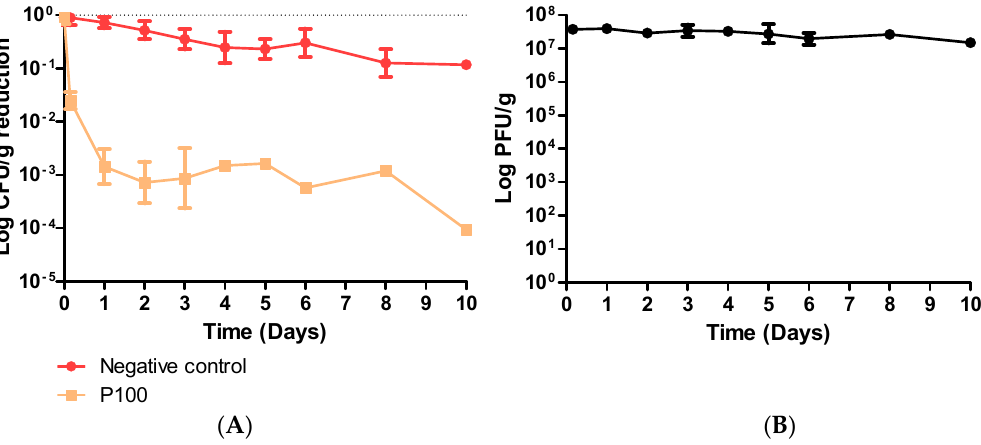
Figure 1. ( A ) E ff ect of P100 on ScottA reduction in coleslaw stored at 4 ◦ C over a 10-day period. Error Figure 1. ( A ) Effect of P100 on ScottA reduction in coleslaw stored at 4 °C over a 10-day period. Error bars represent SEM. Coleslaw was spiked with bacteria (7.1 × 10 5 CFU / g) and phage (4.0 × 10 7 PFU / g). bars represent SEM. Coleslaw was spiked with bacteria (7.1 × 10 5 CFU/g) and phage (4.0 × 10 7 PFU/g). ( B ) P100 titre was also measured throughout the ( B ) P100 titre was also measured throughout the experiment.